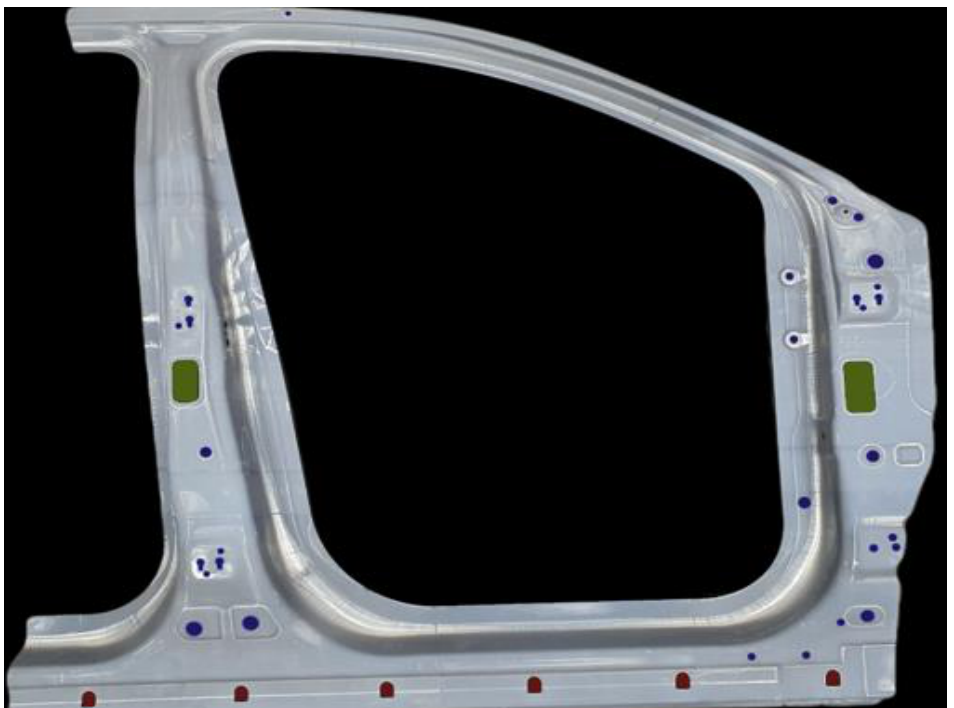
Figure 5. Example of labeled data.